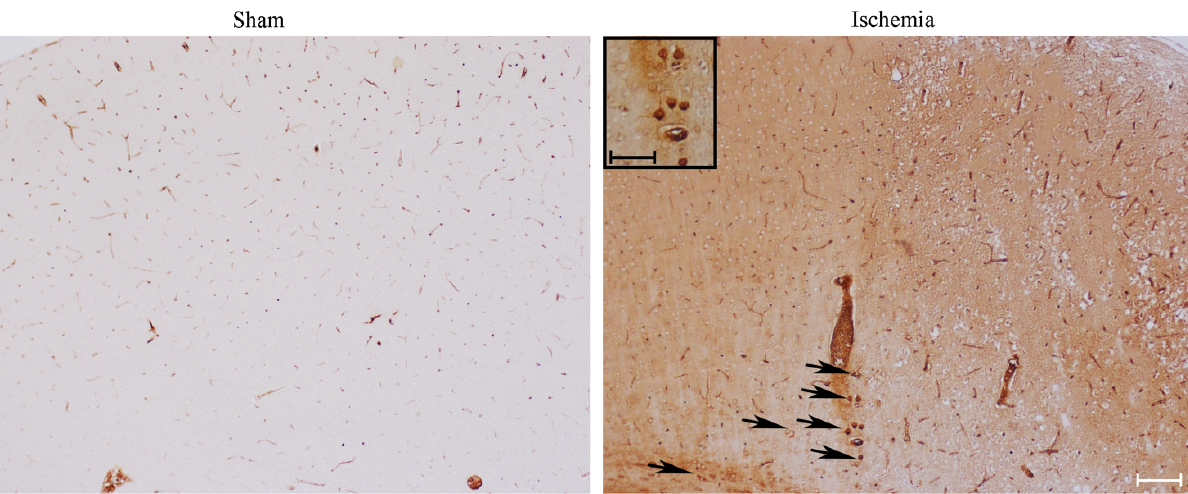
Figure 5. Representative HSP70 immuno-staining. This picture shows Heat Shock Protein 70 positive neurons stained with primary antibodies against inducible HSP70 within the area penumbra (Ischemia, in the representative picture) compared with the homologous area from a control mouse (Sham). Arrows point to HSP70 immuno-positive neurons. Scale bar = 100 μ m; Scale bar (insert) = 50 μ m.